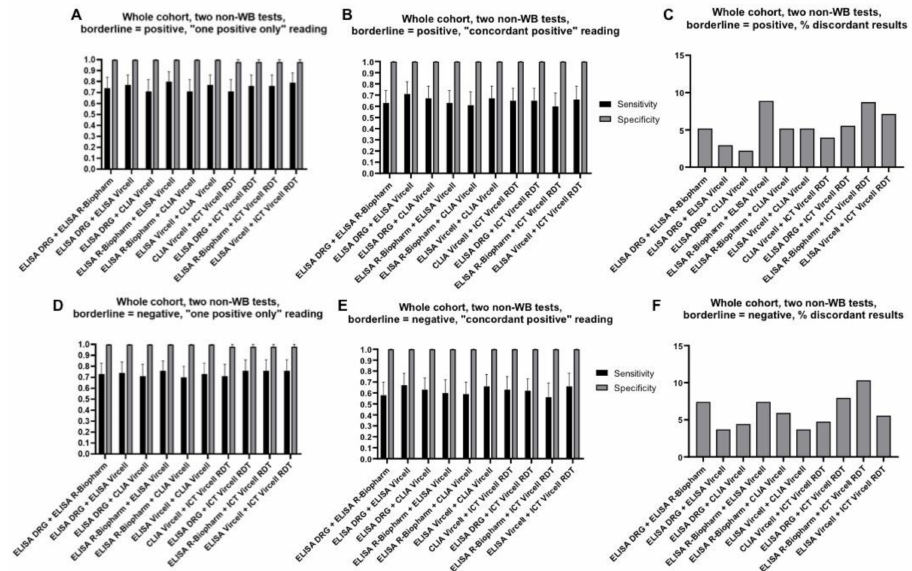
Figure 3. Diagnostic performance of the two non-WB index tests, on the whole sera cohort. Sensitivity and specificity of assays when borderline results were considered as positive and final result interpreted using the “one positive only” approach ( A ) or the “concordant positive” approach ( B ); and when borderline results were considered as negative and final result interpreted using the “one positive only” approach ( D ) or the “concordant positive” approach ( E ). Percentage of discordant results when borderline results were considered as positive ( C ) or negative ( F ). Error bars represent 95% CI. Of note, CLIA Vircell and ELISA Vircell contain the same antigenic preparation, therefore its combined use should be avoided; data relative to this combination are presented for